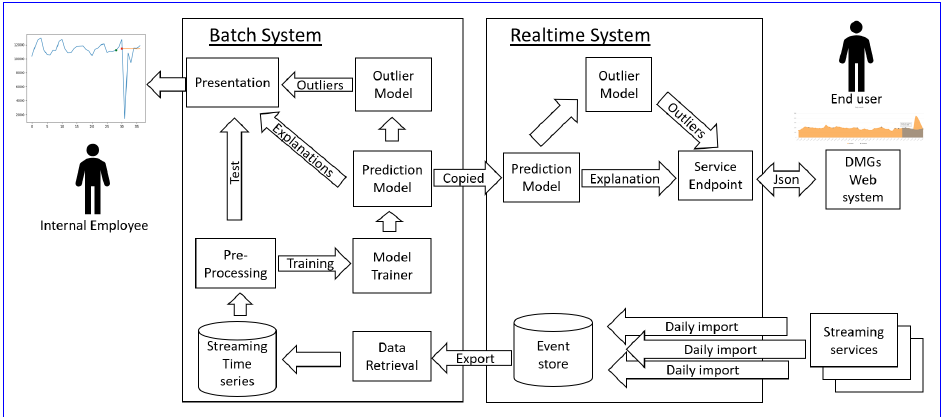
Figure 1. Events are daily imported from music streaming services such as Spotify or YouTube. When an update of the prediction models is required, events are imported and converted to streaming time series. In pre-processing data are filtered (series below a threshold may be removed) and split into a training set and a test set. These are used for the visual evaluation of outliers and explanations. Finally, the model is uploaded to the real-time system where predictions, explanation, and outlier analysis can be accessed by DMGs web front